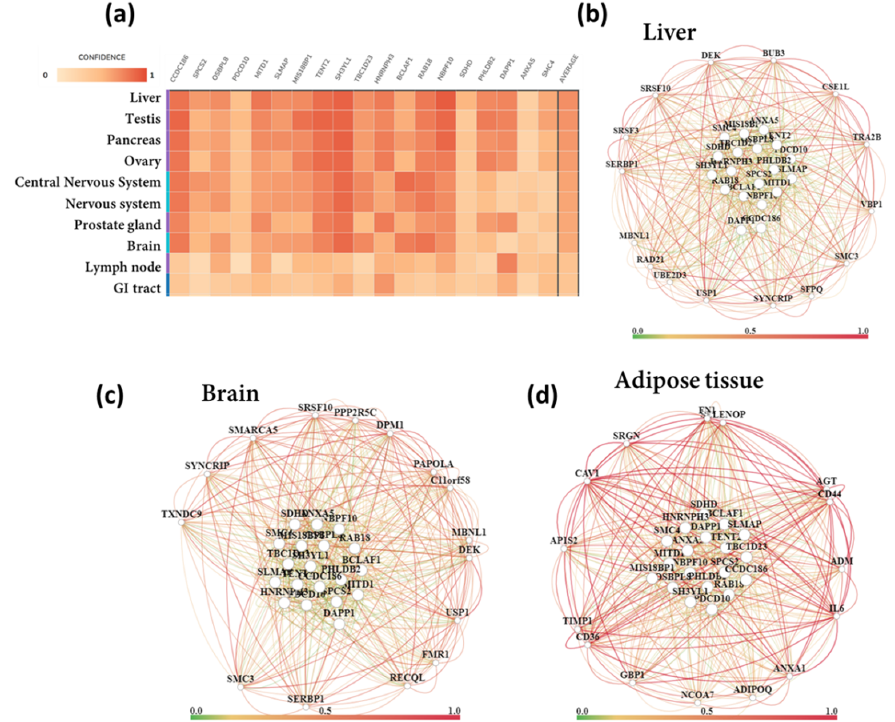
Figure 7. Tissue and biological process-specific functional gene network analysis for the top 19 downregulated DEGs. ( a ) Tissue expression, ( b ) liver-specific functional network, ( c ) brain-specific functional network, ( d ) adipose tissue-specific functional network . Table 2. Top significantly upregulated DEGs and their biological function .